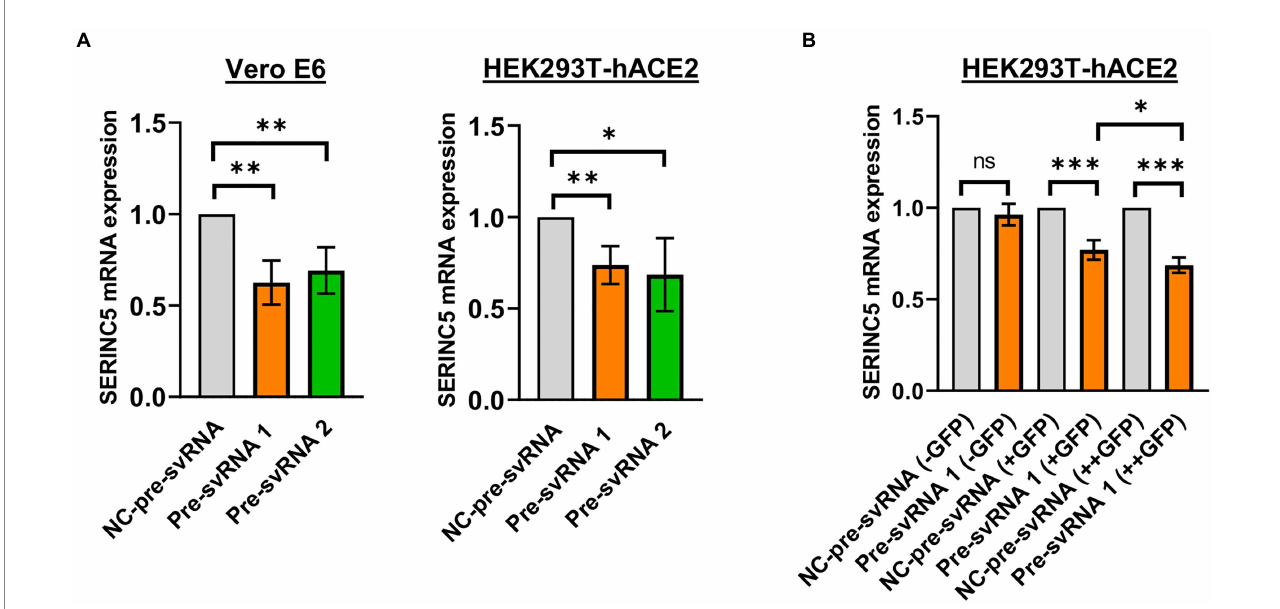
FIGURE 5 Analysis of the levels of SERINC5 mRNA in Vero E6 and HEK293T-hACE2 cells transfected with svRNAs 1 and 2 mimics. (A) RT-qPCR analysis of SERINC5 mRNA level in Vero E6 (left panel) and HEK293T-hACE2 (right panel) cells transfected with an oligonucleotide that mimics the precursor of svRNA 1 or 2 (Pre-svRNA 1 and 2, respectively) or an irrelevant precursor svRNA (NC-pre-svRNA) as a negative control. Data are represented as fold change with respect to values from control samples. (B) RT-qPCR analysis of SERINC5 mRNA level in HEK293T-hACE2 cells co-transfected with Pre-svRNA 1 and a GFP- expressing plasmid. The study was performed on these cells after sorting them into three populations, non-expressing ( − GFP), intermediate expressing (+GFP), and highly expressing (++GFP) GFP cells. Data are represented as fold change with respect to values from negative control-transfected